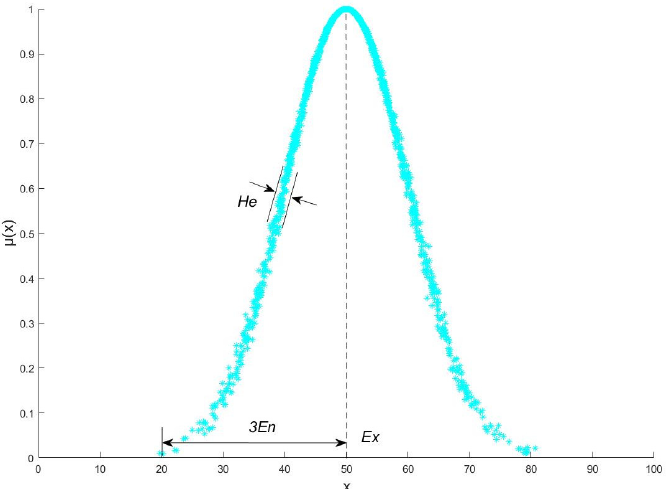
Figure 3. Schematic diagram of the digital features of the cloud model.